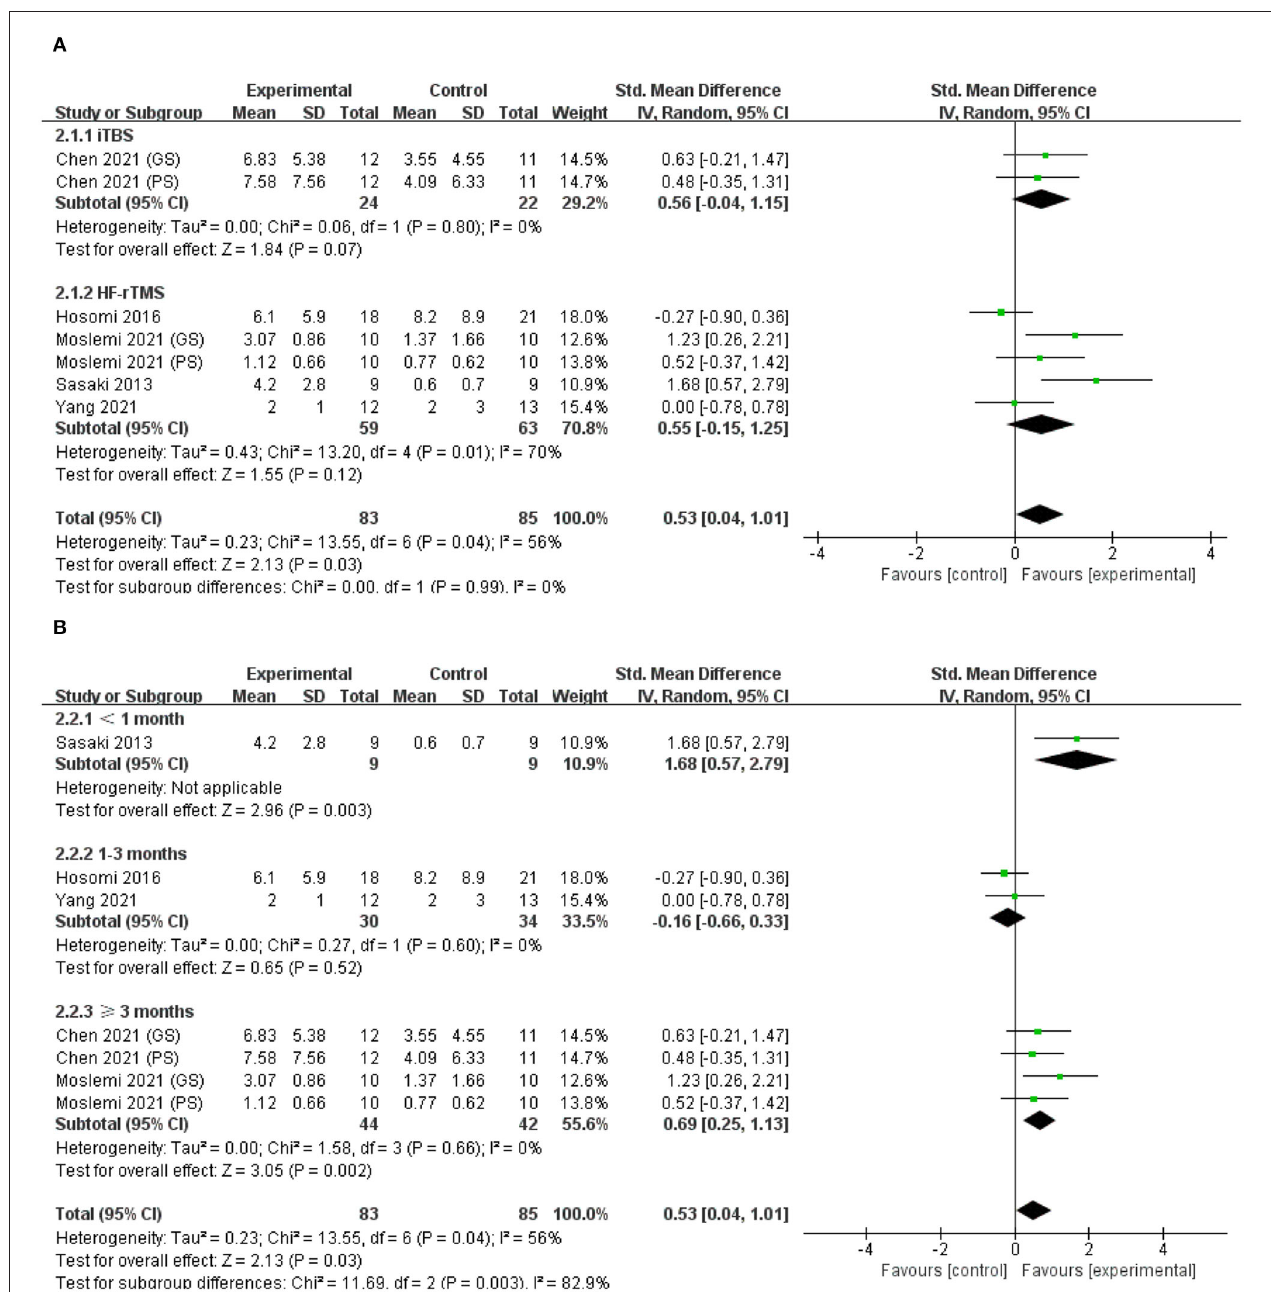
FIGURE 4 | (A) Forest plot from the meta-analysis of excitatory rTMS on hand strength showing estimates of effect size (SMD) with 95% confidence intervals: subgroup analysis based on different types of rTMS. (B) Forest plot from the meta- analysis of excitatory rTMS on hand strength showing estimates of effect size (SMD) with 95% confidence intervals: subgroup analysis based on the duration